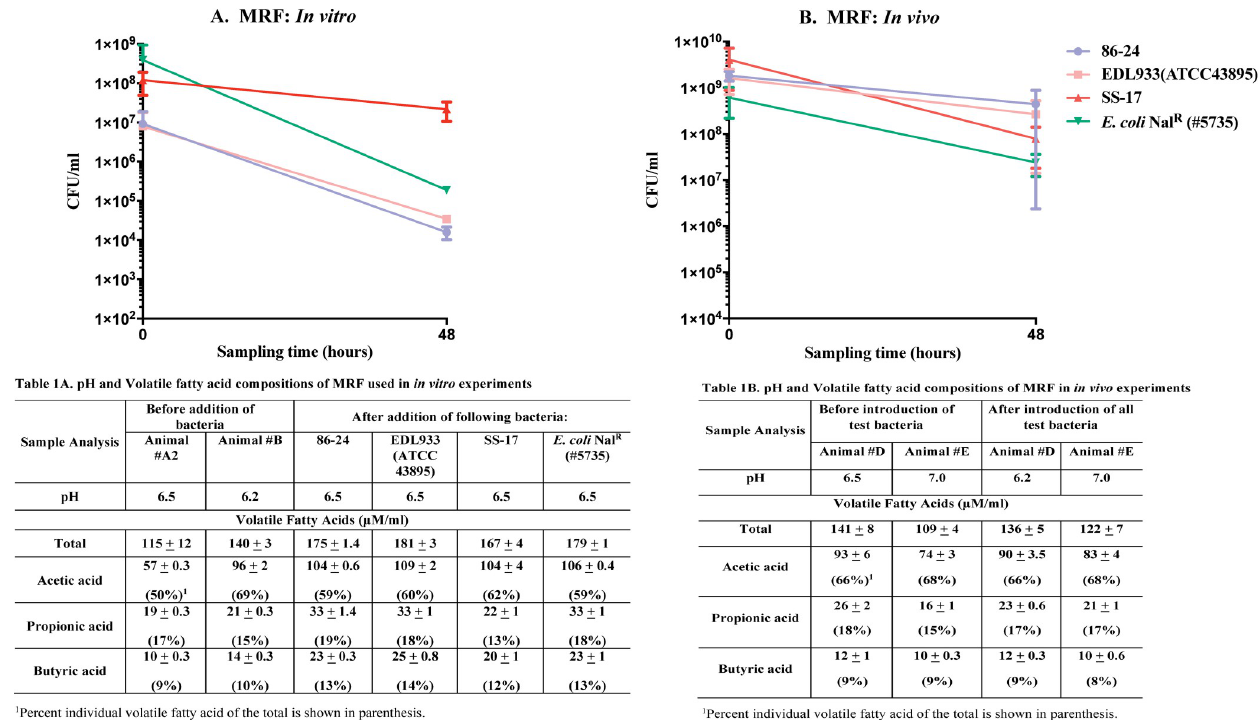
Fig 2. Graphs shown represent survival characteristics of three O157 strains in comparison to E . coli Nal R (#5735), in vitro (A) and in vivo (B), in MRF. Bacterial survival characteristics depicted are following anaerobic incubation for 48 h, in vitro in flasks with MRF or in vivo in the rumen of animals fed the maintenance diet. Viable counts in colony forming units [cfu]/ml, with the standard error of means, are shown in both graphs. Key for each bacterial strain tested is also shown. Inserted tables show pH and VFA composition of MRF used in the in vitro (1A) and in vivo (1B) experiments.